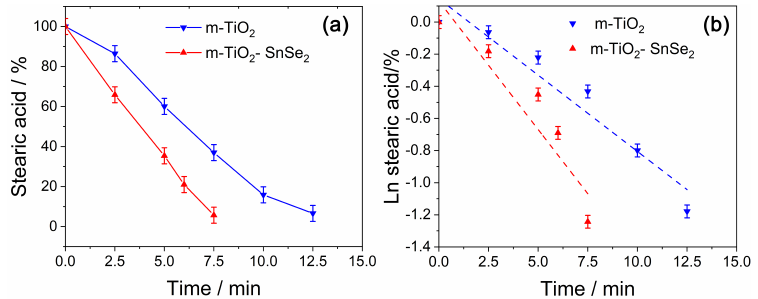
Figure 11. ( a ) Degradation rate (lines are a guide for eyes) obtained by measuring the decrease in intensity of the 2945 cm − 1 C-H 2 stretching mode and ( b ) decay law (dashed lines represent the decay fit) of stearic acid deposited on the different